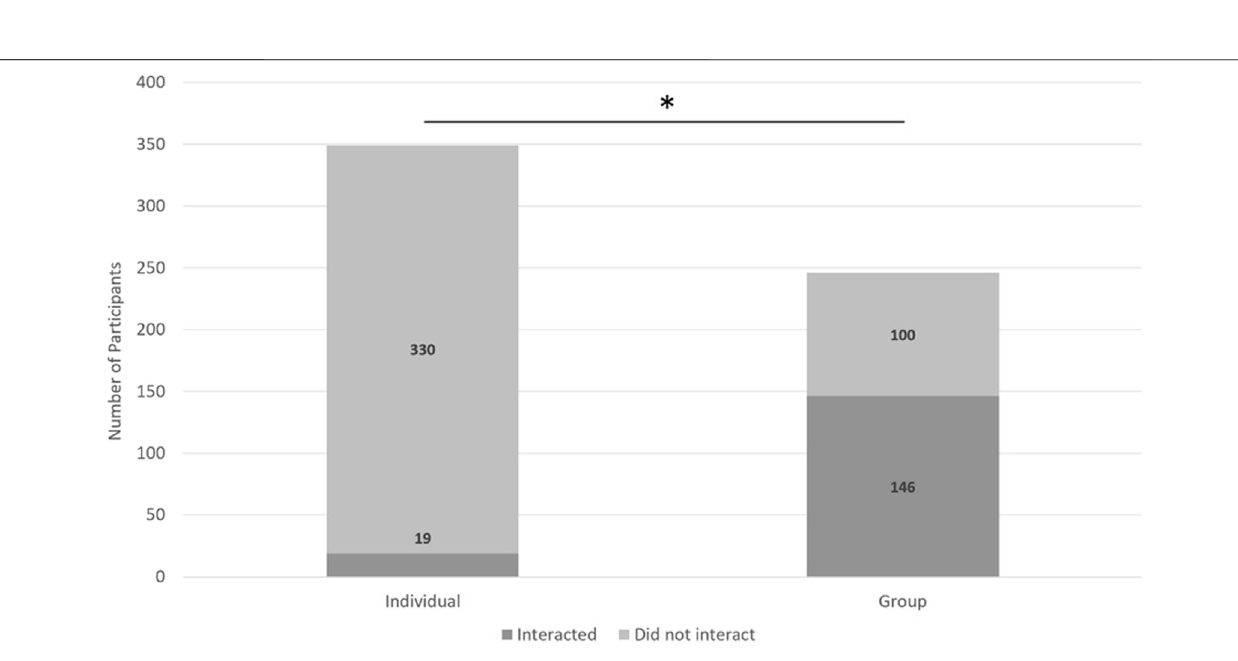
Frontiers in Robotics and AI |